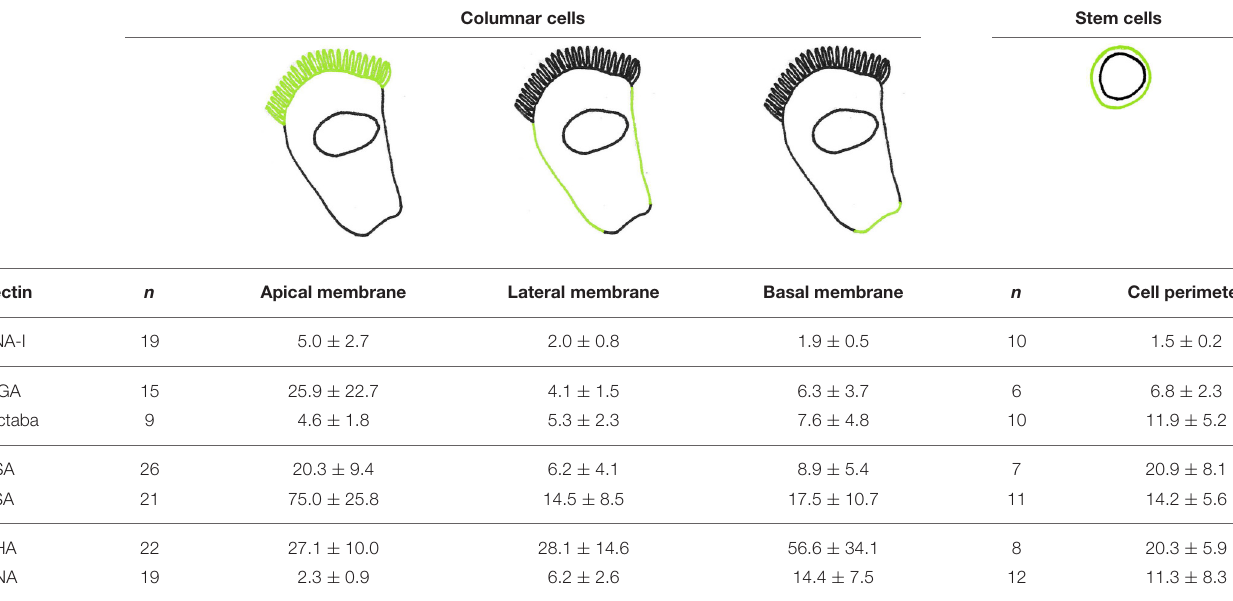
TABLE 1 | Lectin binding intensities to different regions on the surface of columnar cells and stem cells from the larval midgut of Spodoptera littoralis . Columnar cells